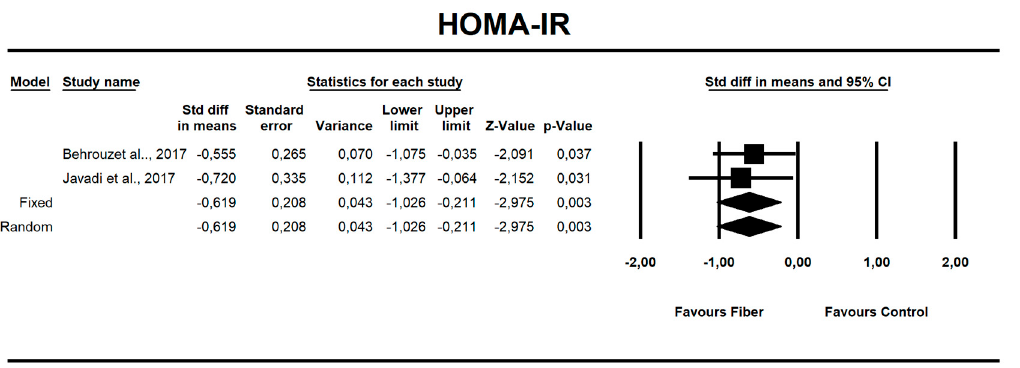
Figure 8. E ff ect size and standardized mean di ff erence (SMD) for insulin in people supplementing fiber Figure 8. Effect size and standardized mean difference (SMD) for insulin in people supplementing Nutrients 2020 , 12 , x FOR PEER REVIEW 12 of 19 vs. controls. df(Q) = 1, p = 0.864, I-squared = 0.0. fiber vs. controls. df(Q) = 1, p = 0.864, I-squared = 0.0. Figure 8. Effect size and standardized mean difference (SMD) for insulin in people supplementing fiber vs. controls. df(Q) = 1, p = 0.864, I-squared = 0.0.